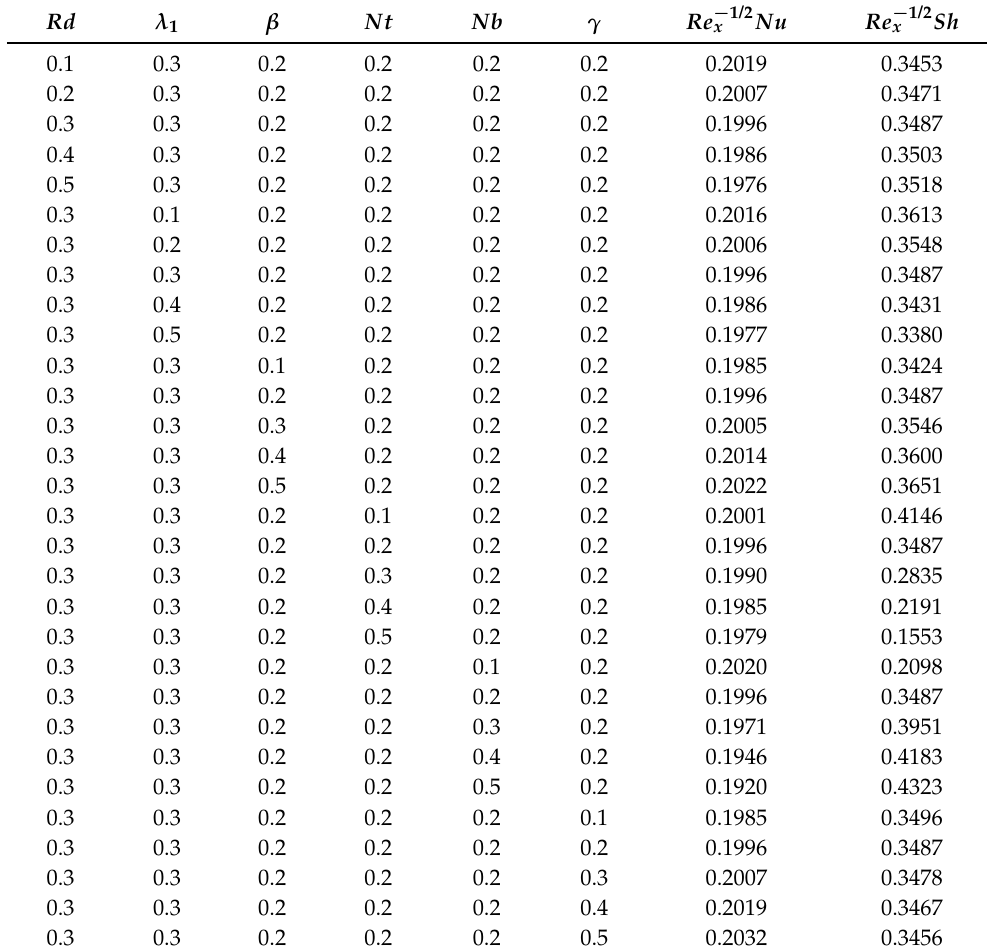
Table 3. Numerical values of the Nusselt number and Sherwood number for the fixed values α =